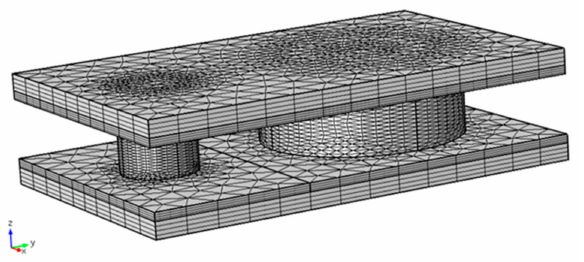
Figure 9. Mesh implemented in the parametric sweep, refined in the vicinity of regions with strong gradients of current and heat